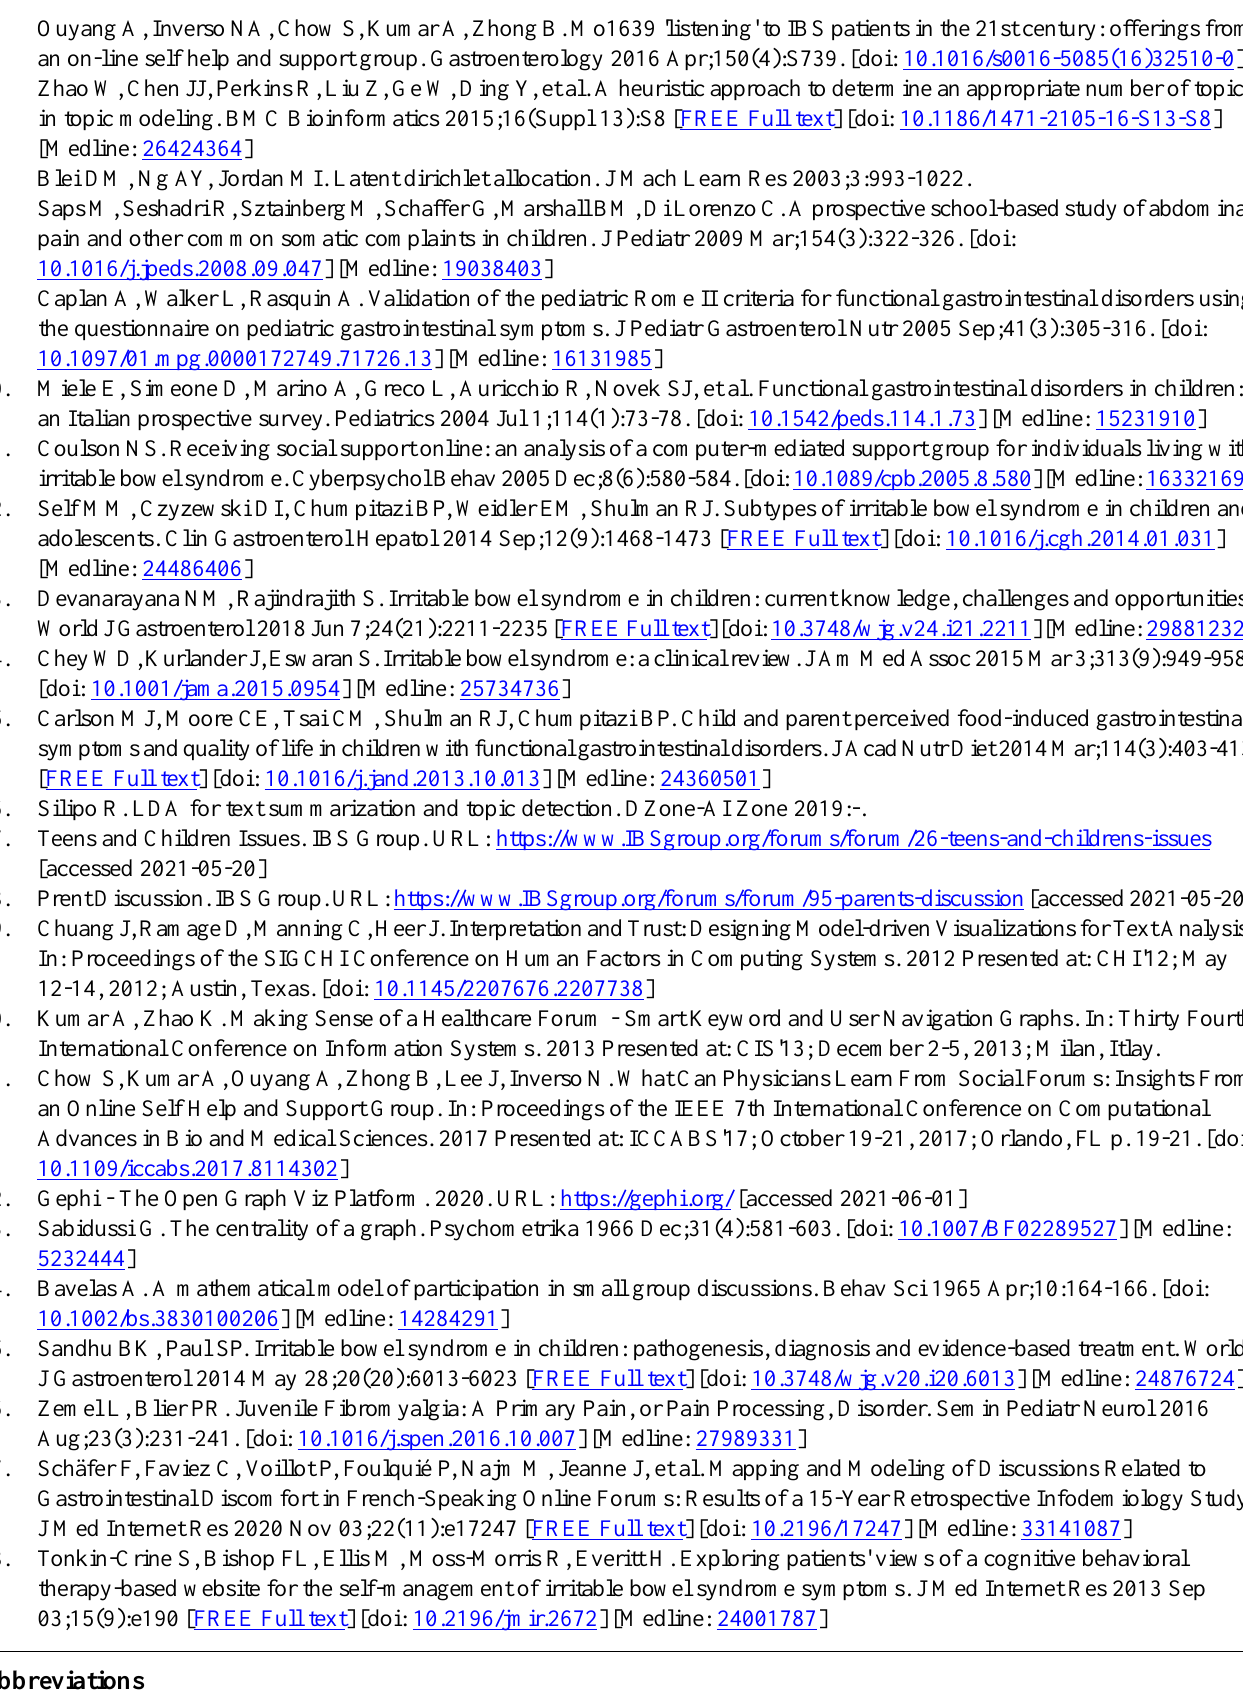
IBS: irritable bowel syndrome LDA: latent Dirichlet